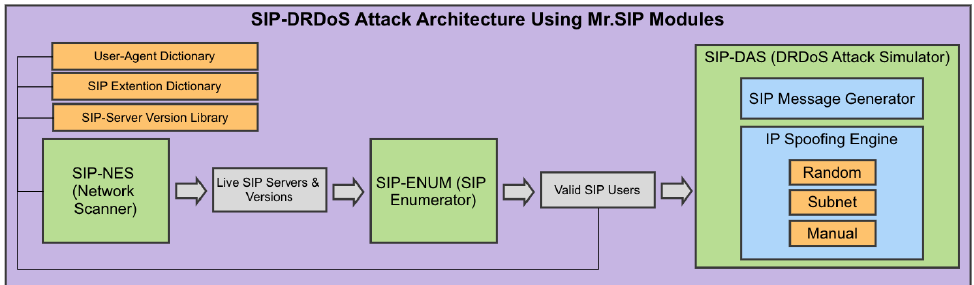
Figure 3. Architecture of Mr.SIP, the attack tool utilized in this